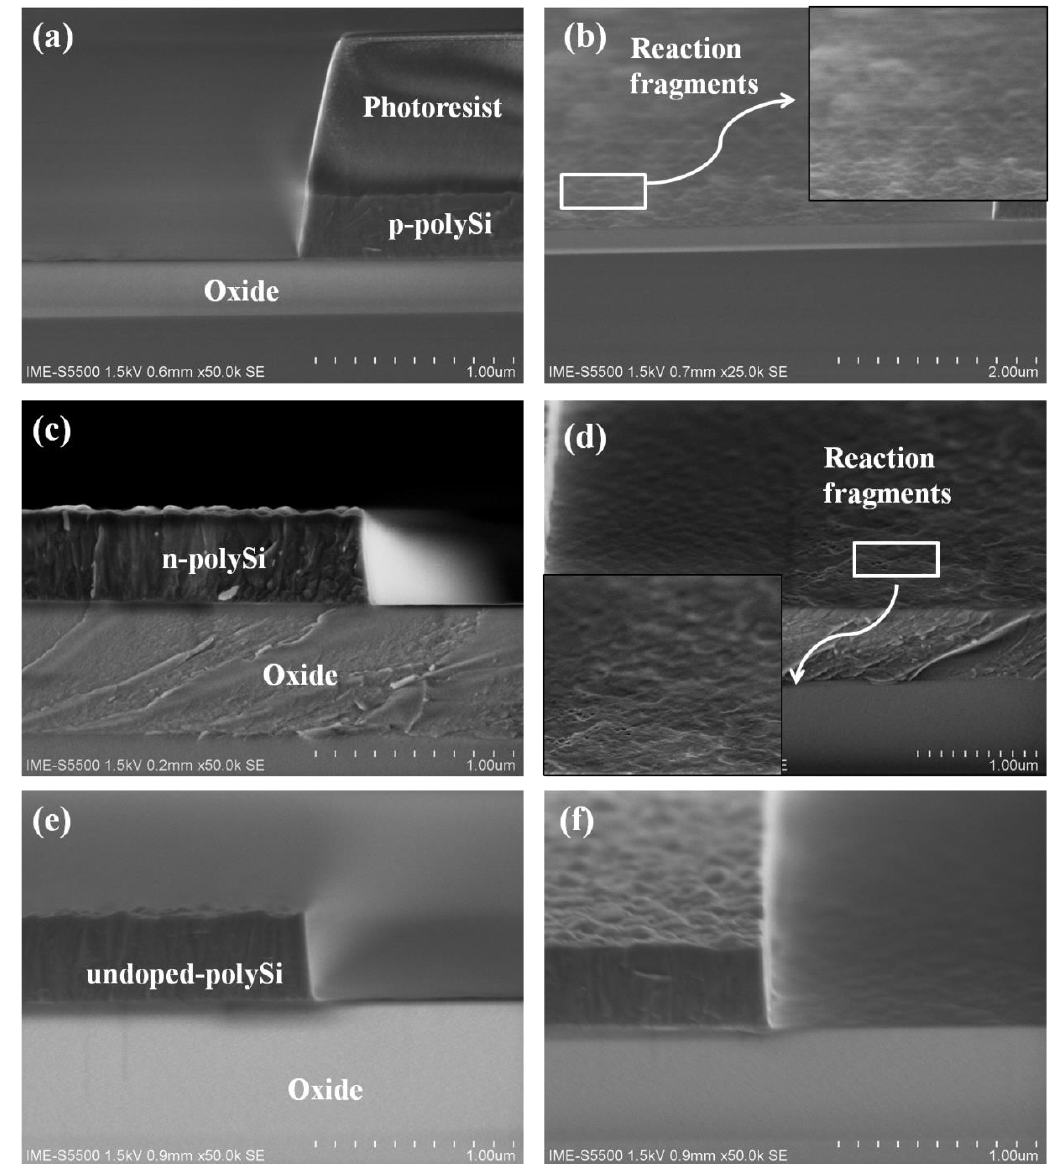
Figure 2. SEM images after etching of three types of polysilicon: ( a , b ) p-type polysilicon after etching, ( c , d ) n-type polysilicon after etching, ( e , f ) undoped polysilicon after etching. Images in ( a , c , e ) are the cross section views of polysilicon structures. Images in ( b , d , f ) are taken with a tilting angle of 20°.